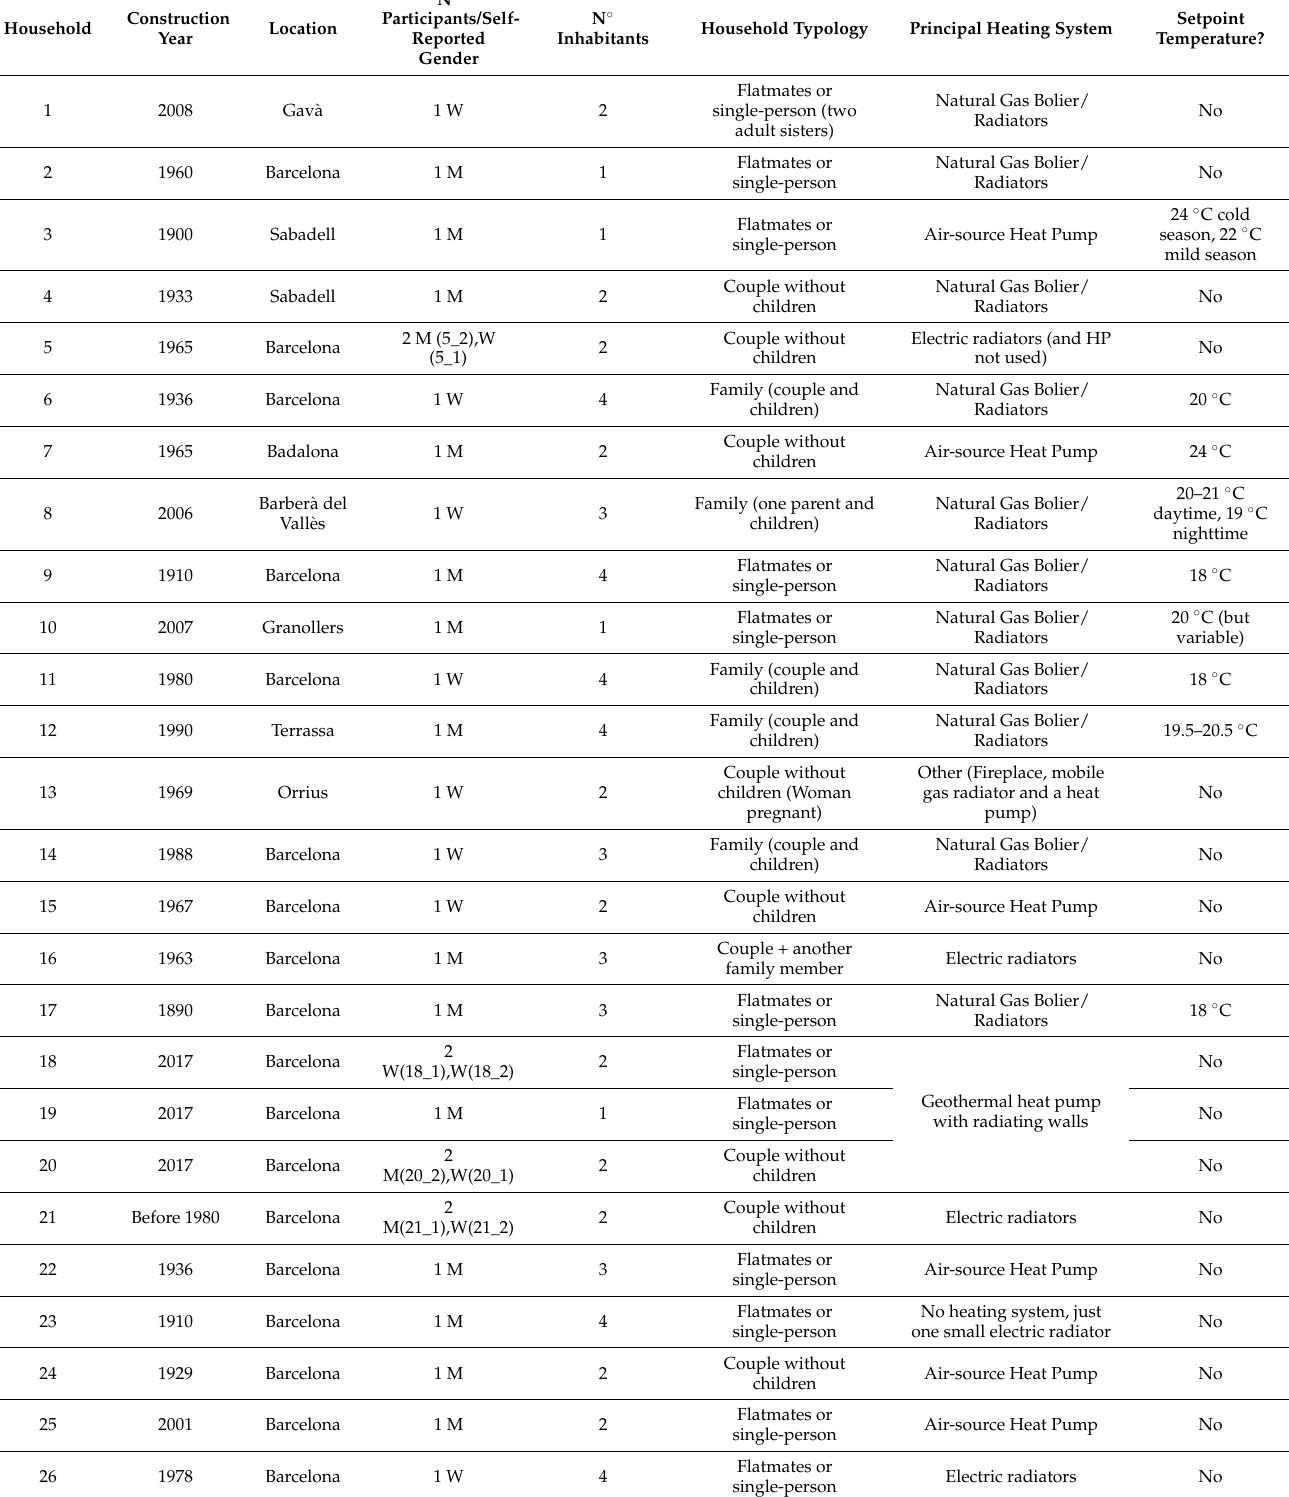
Table 6. Household characterization of the sample